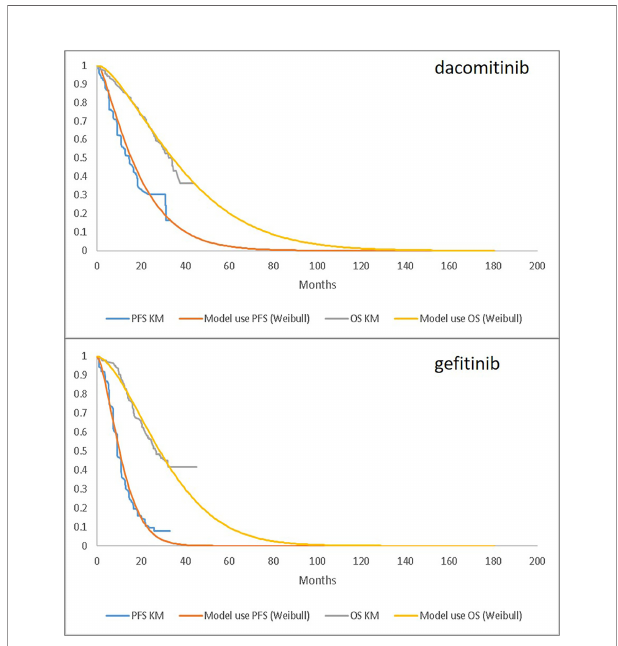
FIGURE 1 | Parametric Fitting (Weibull) Compared to Observed KM Data: PFS (based on independent review committee) and OS for dacomitinib (upper) and ge fi tinib (lower). PFS, progression-free survival; OS, overall survival; KM,